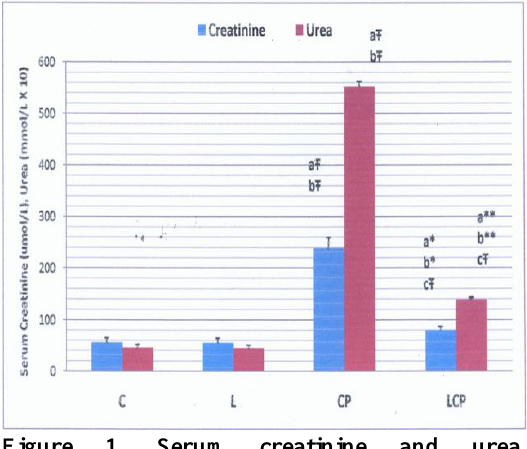
Figure 1. Serum creatinine and urea concentrations in different groups of rabbits.